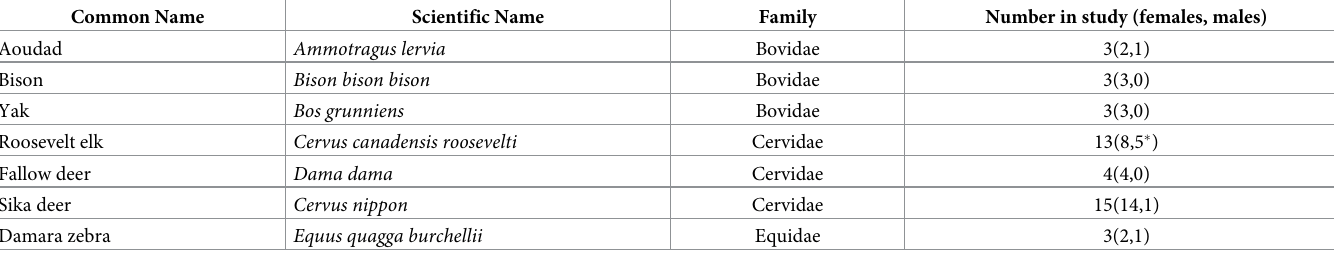
Table 1. Adult animals included in the study. The following animals were immobilized and sampled at Wildlife Safari